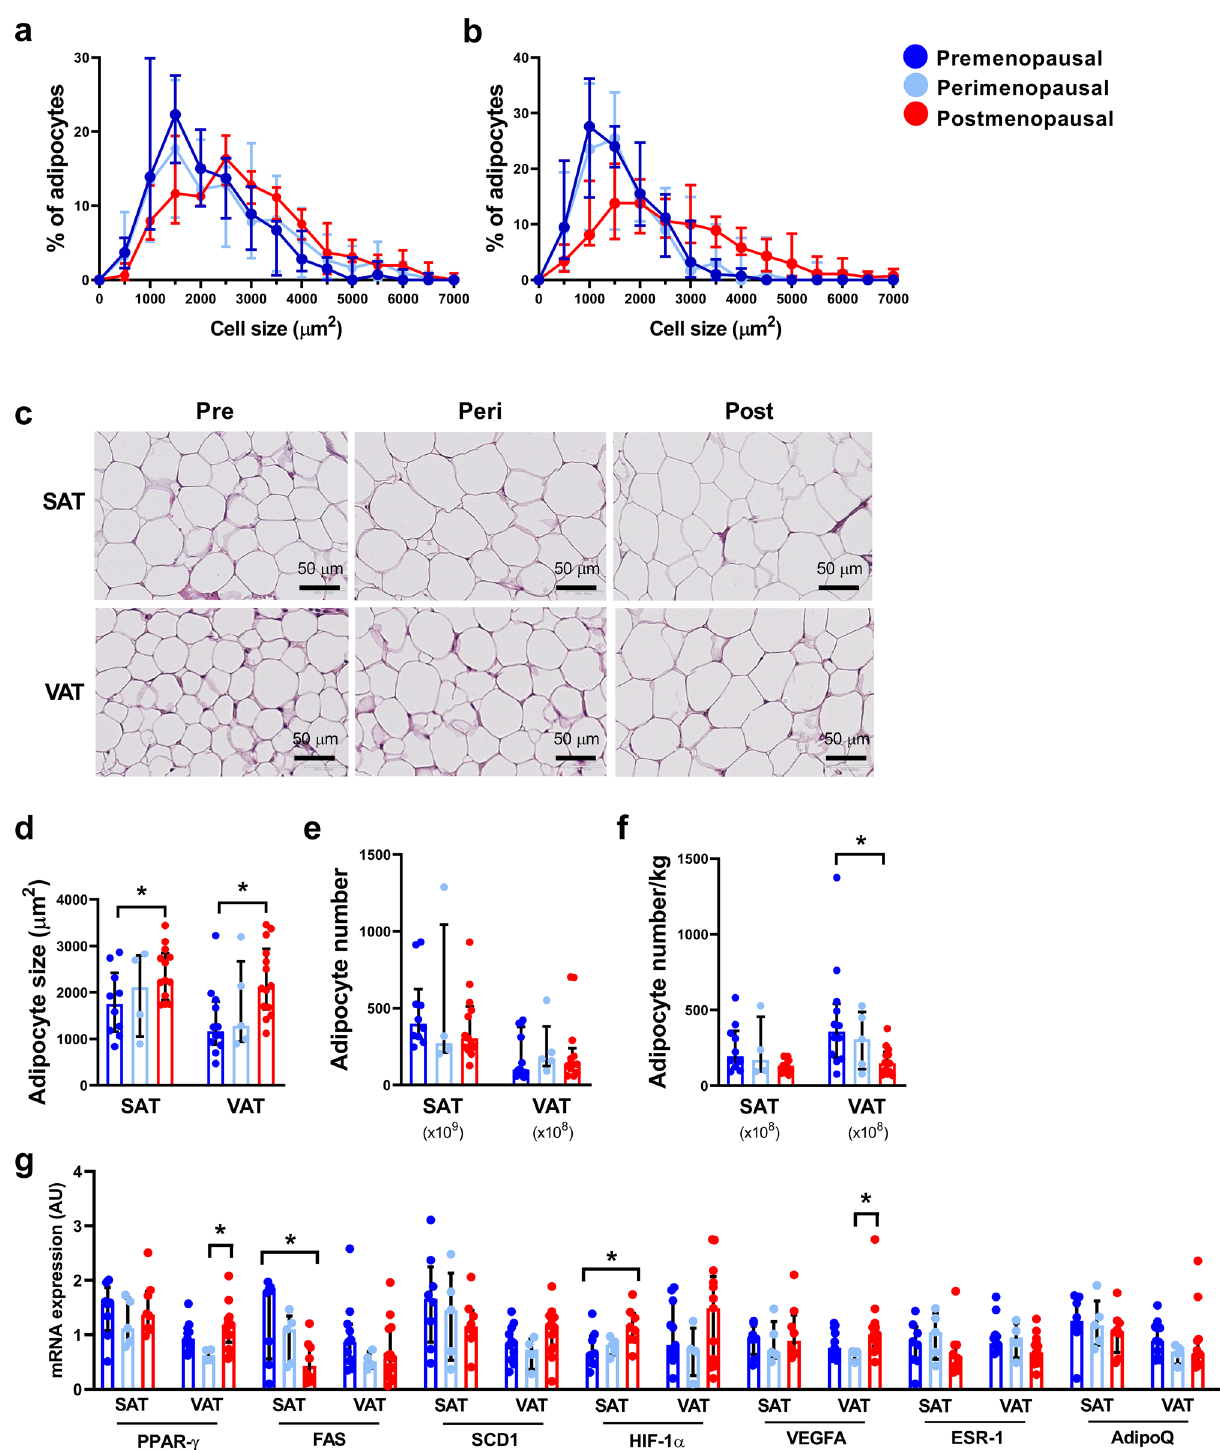
Figure 1. Adipocyte size and mRNA expression in subcutaneous adipose tissue (SAT) and visceral adipose tissue (VAT) in pre- (SAT, n = 10; VAT, n = 12), peri- (SAT and VAT, n = 5), and postmenopausal women (SAT, n = 12; VAT, n = 14). ( A ) Adipocyte size distribution in SAT in pre-, peri-, and postmenopausal women, ( B ) Adipocyte size distribution in VAT, ( C ) Representative HE-section of SAT and VAT, ( D ) Adipocyte size in SAT and VAT, ( E ) Adipocyte number in SAT and VAT, ( F ) Adipocyte number per kg fat in SAT and VAT, ( G ) mRNA expression of Peroxisome Proliferator-Activated Receptor (PPAR)-γ, Fatty Acid Synthase (FAS), Steraoyl-CoA Desaturase (SCD)1, Hypoxia-inducible factor (HIF)-1α, Vascular Endothelial Growth Factor A (VEGFA), Estrogen Receptor 1 (ESR1), and Adiponectin (AdipoQ) in both SAT and VAT. Data are presented as median (interquartile range). *Significant difference, p <